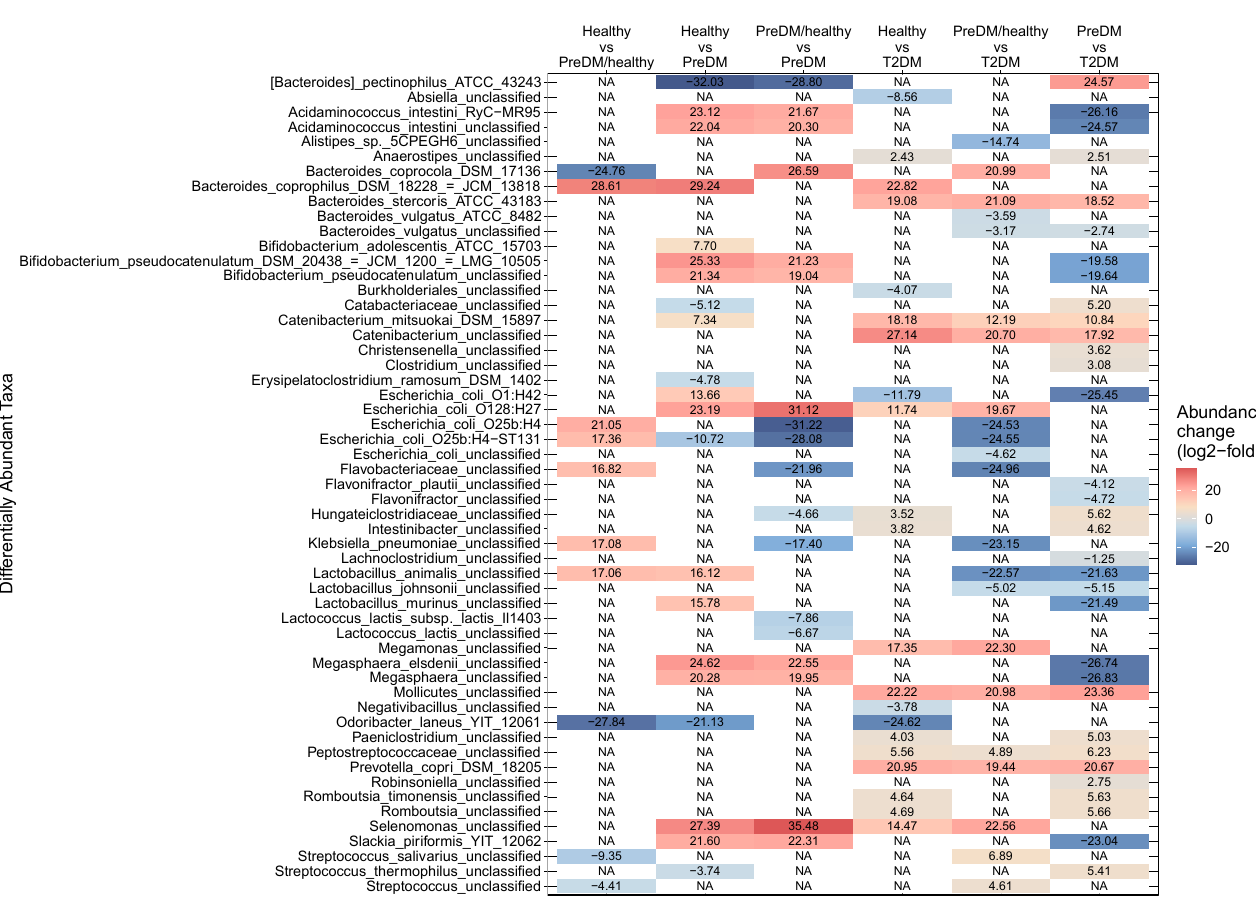
Figure 3. Observed fold change magnitudes for all 55 differentially abundant taxa present in all comparisons of health status groups. Columns indicate each comparison, and rows show taxonomic assignment for each OTU. Color indicates the log2-fold abundance change in each taxon for each comparison. For positive log2-fold change, the health status category before “vs” in each comparison label is more abundant than the category after the “vs”, and vice versa for negative log2-fold change. For example, when comparing “Healthy vs T2DM,” a positive value indicates a taxon that is more abundant in Healthy, and a negative value indicates a taxon that is more abundant in T2DM. T2DM: Type 2 diabetes; PreDM: prediabetes.